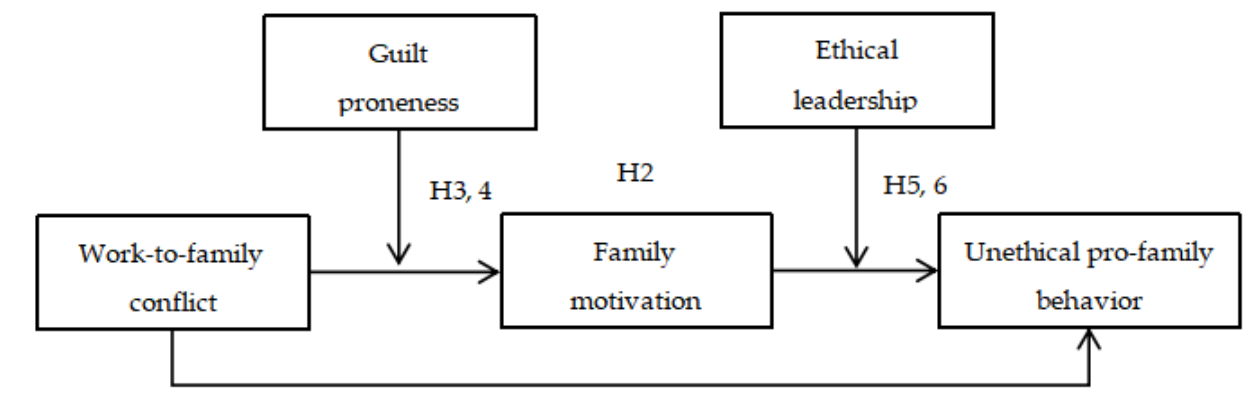
Figure 1. Theoretical Model.